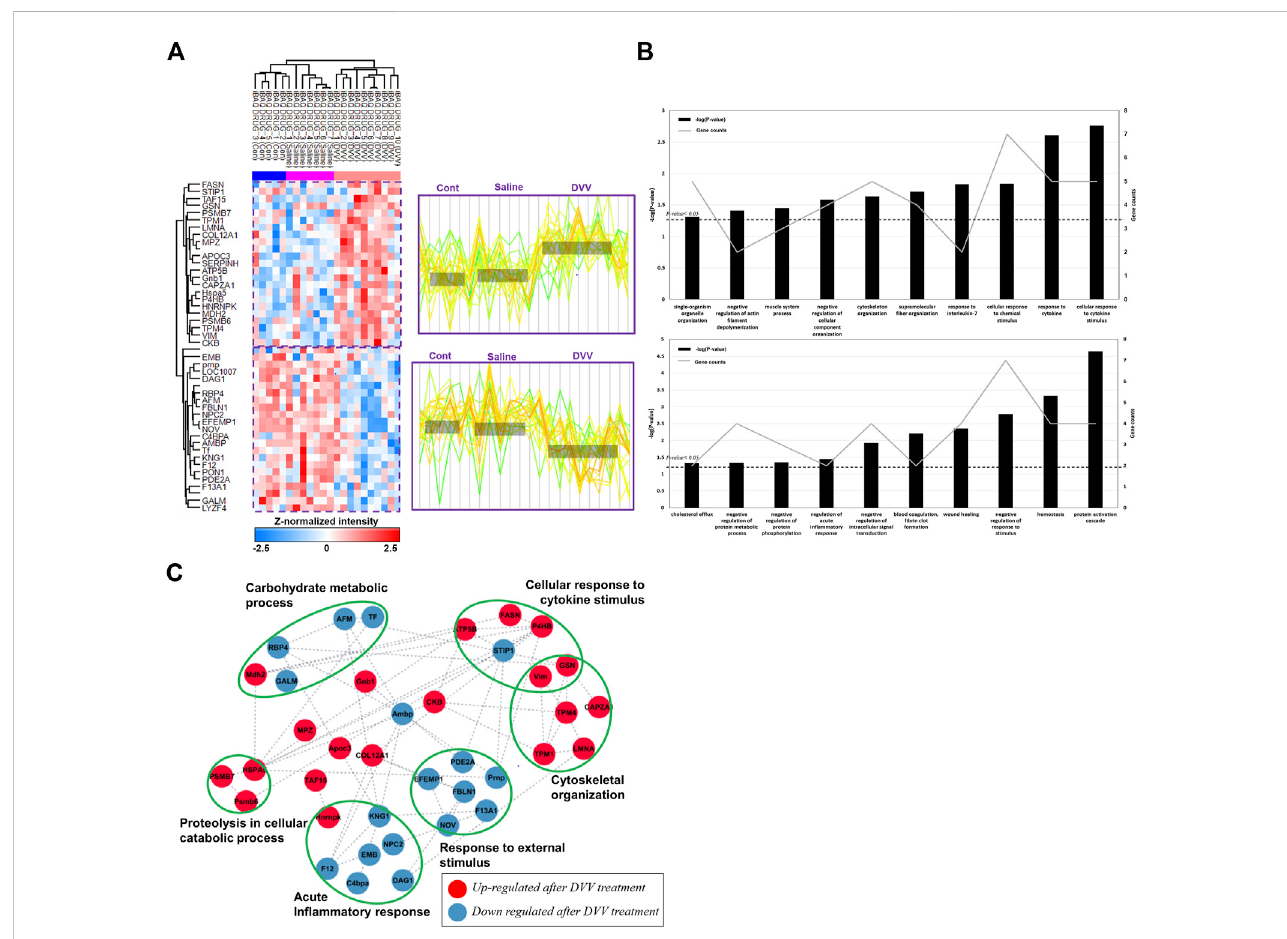
Hierarchical clustering with protein expression of DEPs and gene ontology results after LC-MS/MS analysis. (A) Hierarchical clustering of 46 DEPs after one-wayANOVA-test( p -value < 0.05).Theidenti fi edDEPsconsistedtwospeci fi cclusterswhicharespeci fi callyupregulatedinDVVgroupanddownregulated inDVVgroup. (B) The biological process of DEPs that are included intwo different clusters by gene ontology analysis and thenumber of proteins categorized in each process. (C) The protein-protein interaction (PPI) of DEPs, clustered with speci fi c biological process. The red node represents upregulated proteins after DVV treatment and blue node represents downregulated proteins after DVV